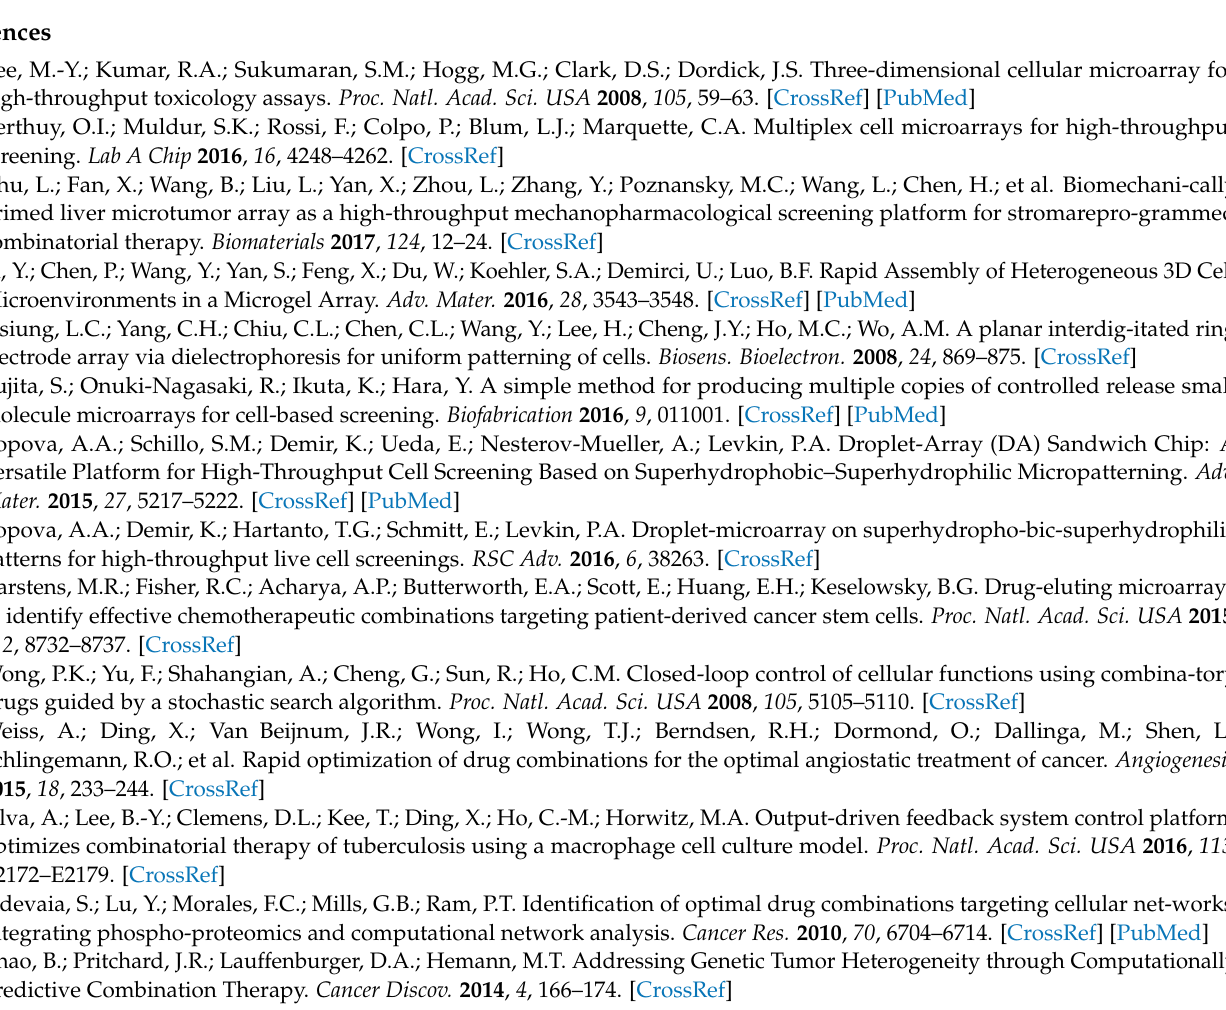
Figure S2: Cell viability of MCF-7 cells during the cocktail treatments by the µ CA chip, Figure S3: Cell viability of MCF-7 cells under cocktail treatments by the 96-well